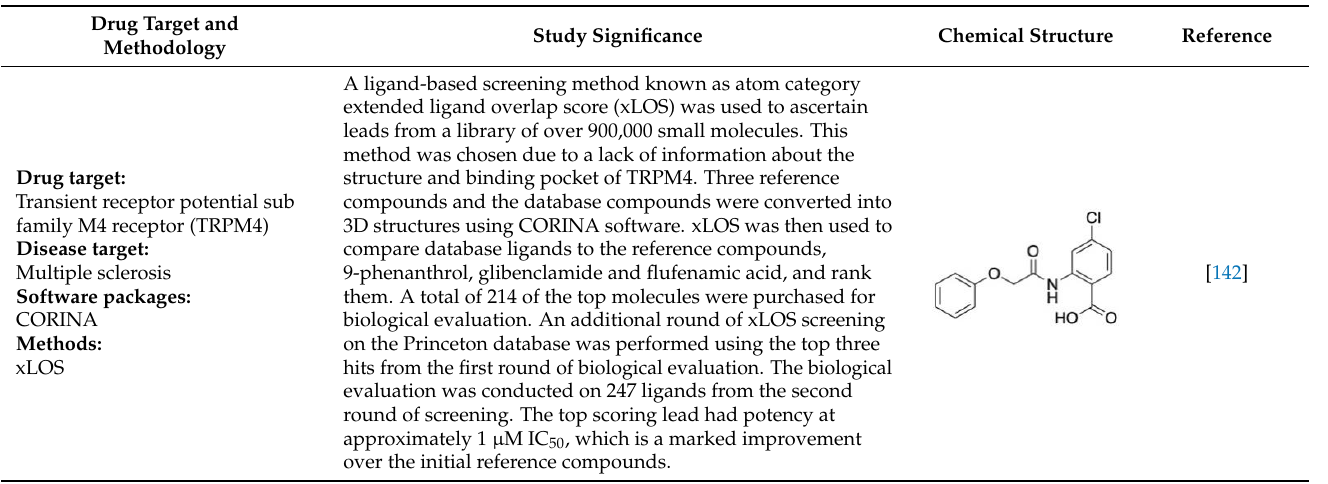
Table 2. Further examples of computer-aided drug discovery for new neurological and psychiatric treatments from the literature.